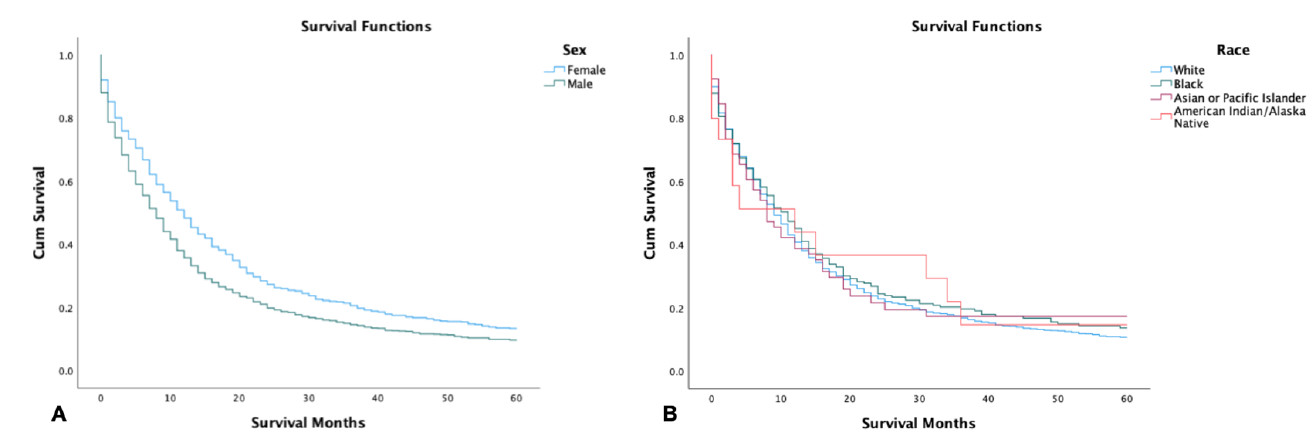
Figure 1. Kaplan – Meier survival graph of 2126 patients with combined small-cell lung cancer from SEER database by (2000–2018). ( A ) Survival by sex; ( B ) survival by race. Log rank (Mantel–Cox) analysis ( χ 2 ) performed on each independent variable. Sex was found to be a significant independent variable with p < 0.001, while race was not ( p = 0.8).